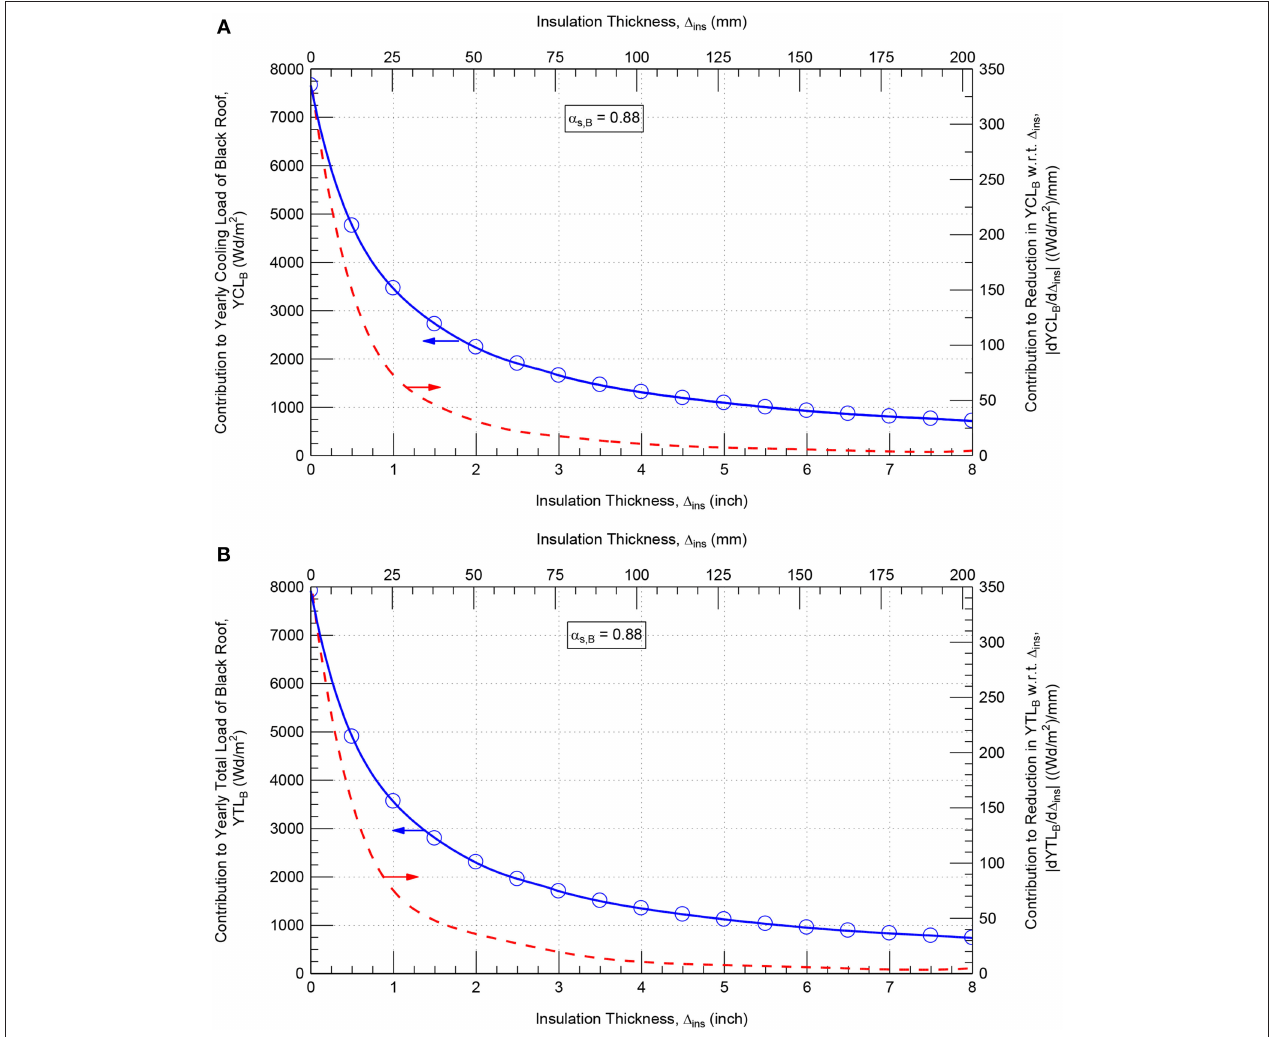
FIGURE 13 | Effect of the insulation thickness on the contribution to the yearly cooling energy load (A) , yearly total energy load (B) and the reductions in these loads with respect to insulation thickness for black